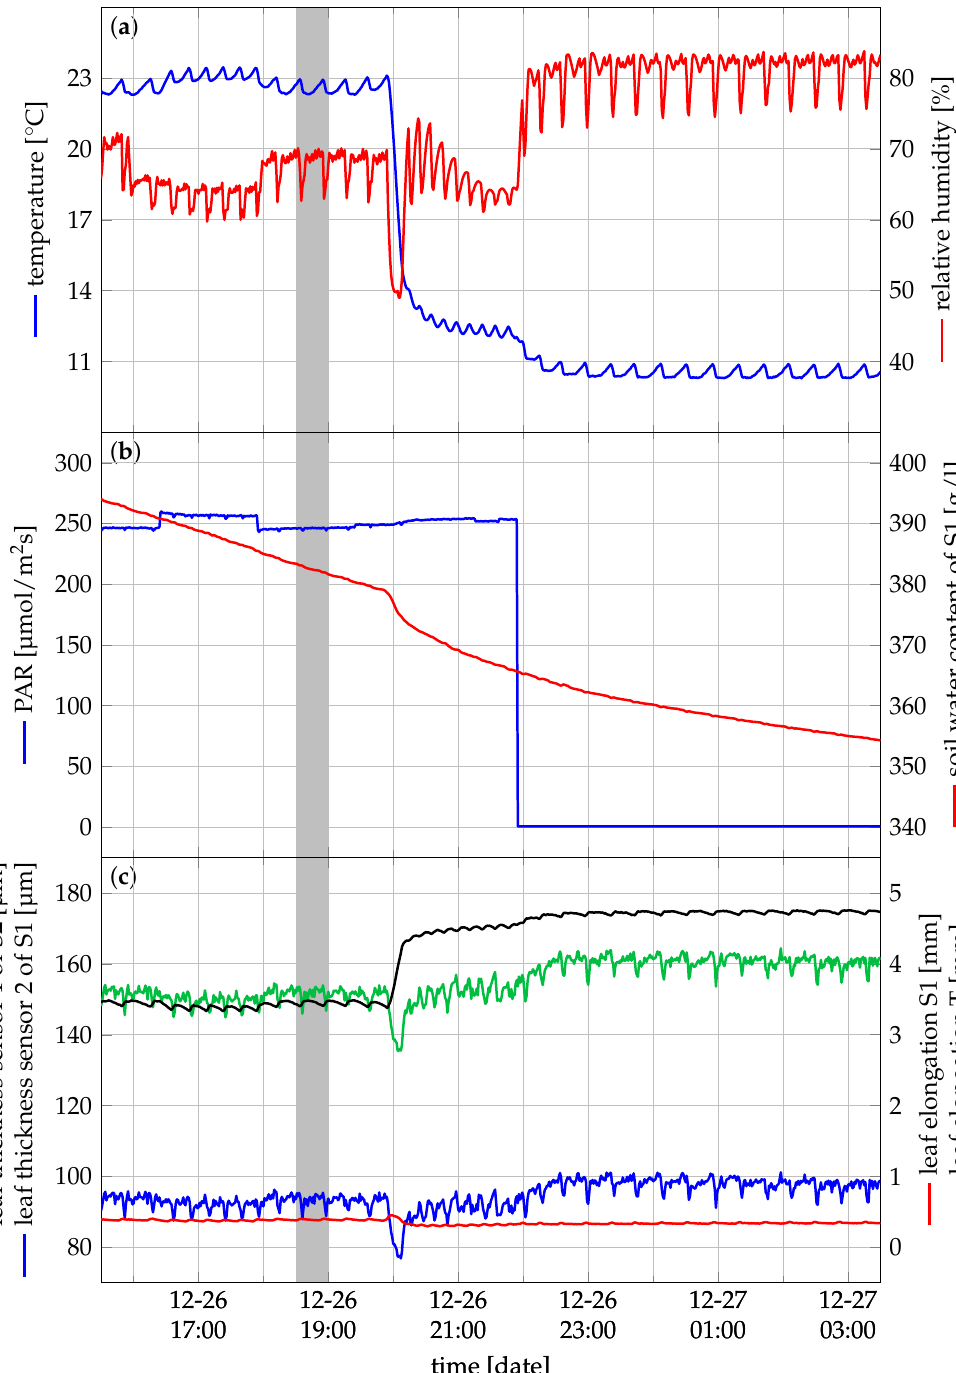
Figure 7. This figure is a detailed zoom of the grey shaded in Figure 5 to visualise the accuracy of the system. A further zoom of the grey shaded area in this figure (18:30 to 19:00 on 26 December) is depicted in Figure